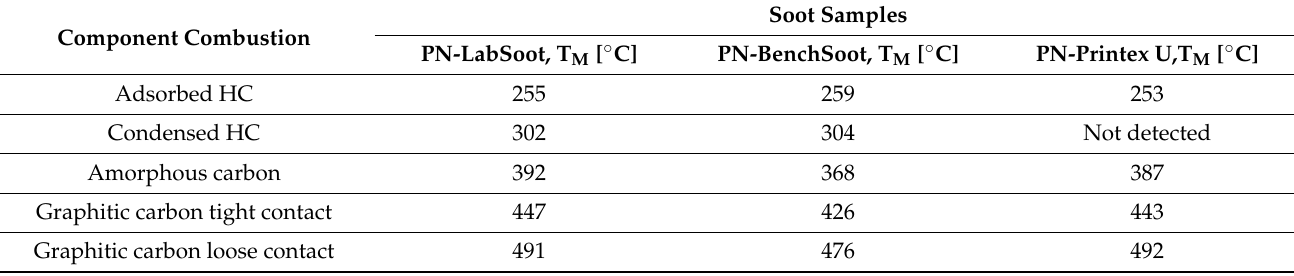
Table 5. Soot deposited on ceramic papers with CeO 2 binder: Maximum combustion rate tempera- tures (T M ) of the different fractions soot